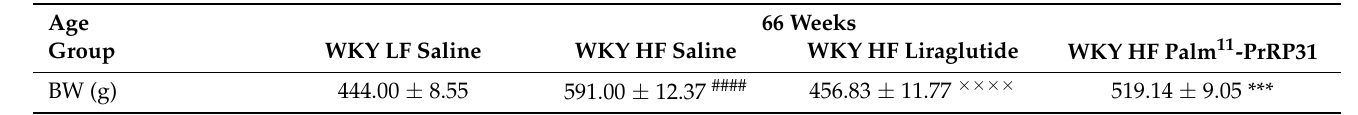
Table 3. Morphometric and metabolic parameters analyzed in fasted plasma of WKY LF saline, WKY HF saline, WKY HF liraglutide and WKY HF palm 11 -PrRP31 at the end of the experiment (66 weeks of